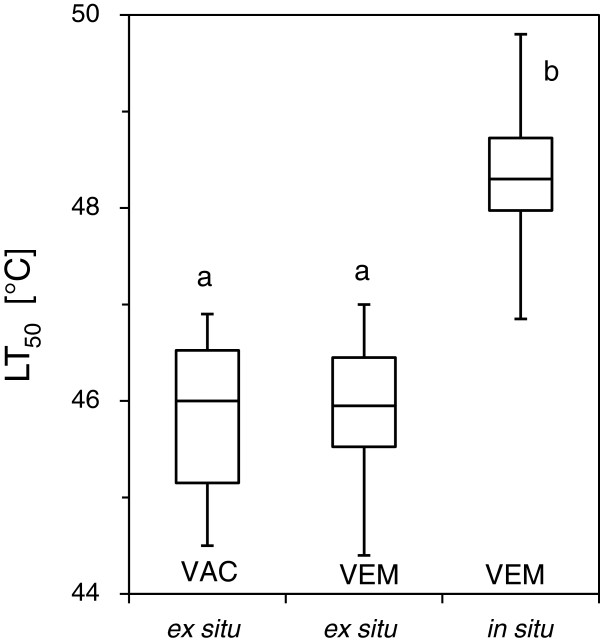
Leaf heat tolerance of V. gaultherioides. The controlled heat exposure took place on 24 July 2012 on Mt. Patscherkofel (1950 m a.s.l.). Viability assays were performed two days later. Heat tolerance (LT50) of detached leaves (ex situ) as assessed by computer based visual assessment (VAC) did not differ from results assessed by the visual estimation method (VEM), confirming that for experienced users assessment of leaf injury by visual estimation may represent a fast and viable method to assess heat damage of attached leaves. When the heat treatment was conducted in situ heat tolerance was significantly higher than heat tolerance that was measured on detached leaves. In both cases the controlled heat exposure took place in darkness. Boxes: median, upper and lower quartile. Whiskers: maximum, minimum. Significant differences between mean values of heat tolerance based on ANOVA and the Bonferroni - test and are indicted by different letters (P < 0.01).